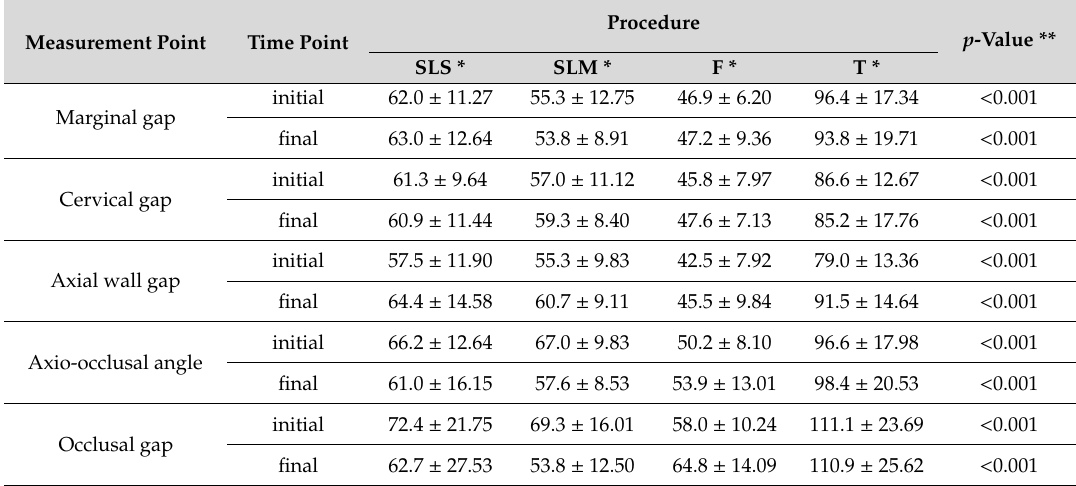
Table 1. Mean values for measured points for each